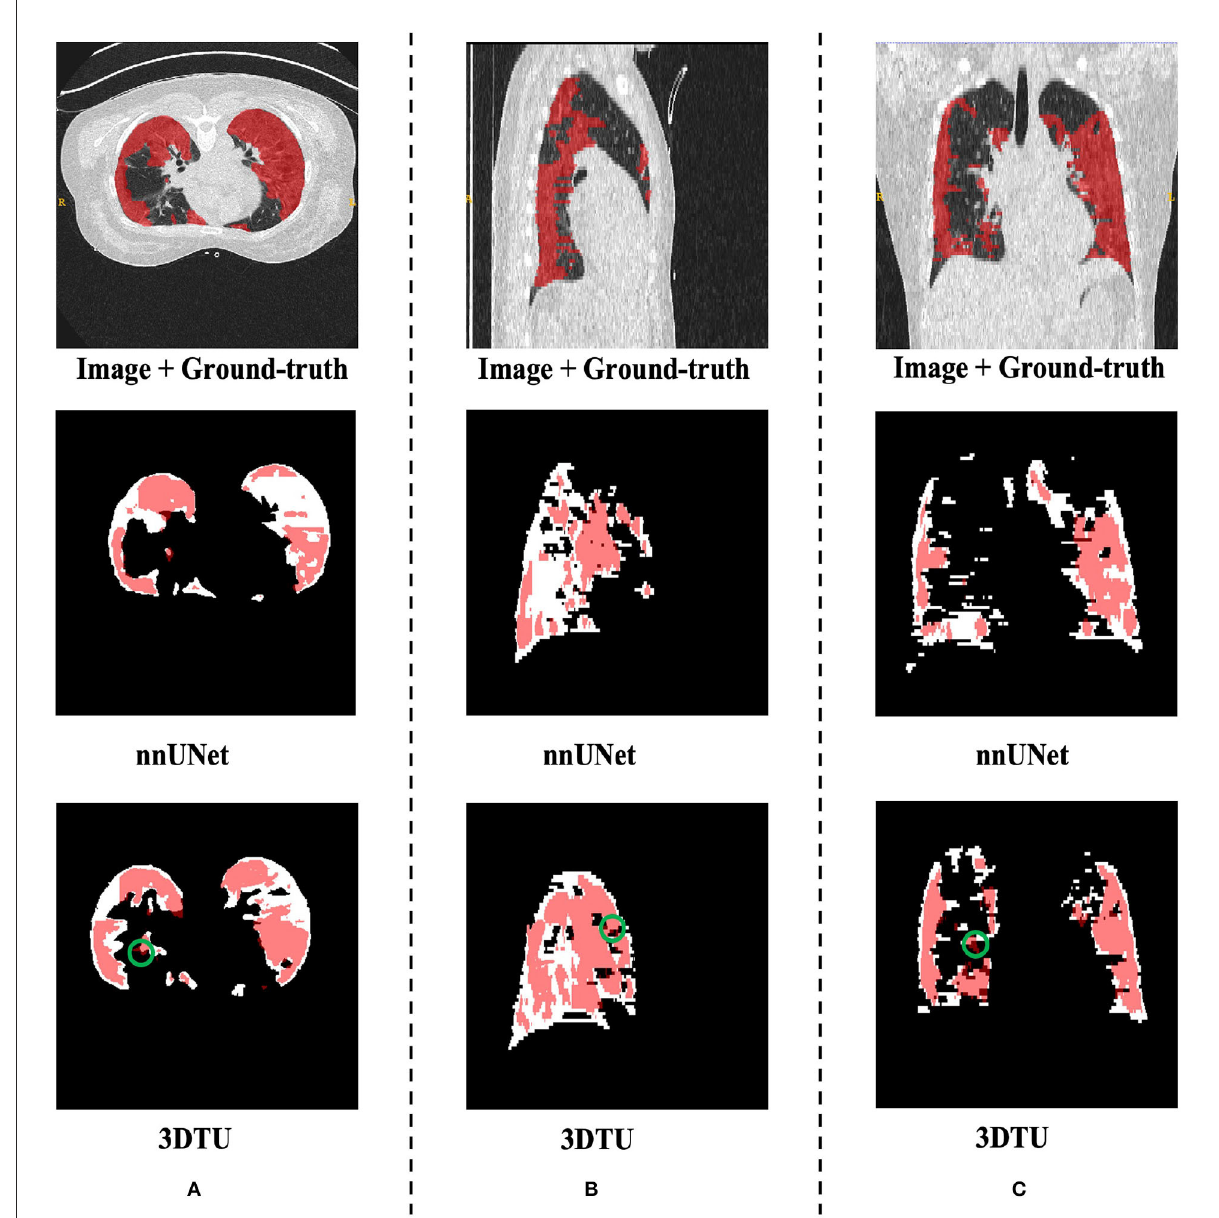
FIGURE4 Visualization of the infection segmentation results on the Covid20 dataset produced by our 3DTU and nnUNet. Columns (A–C) show the x – y plane, y – z plane, and x – z plane of 3D segmentation predictions, respectively. The true-positive regions are highlighted in pink. The false-negative regions are highlighted in red (e.g., the green circle regions in the last row). Better view with colors and zooming in.